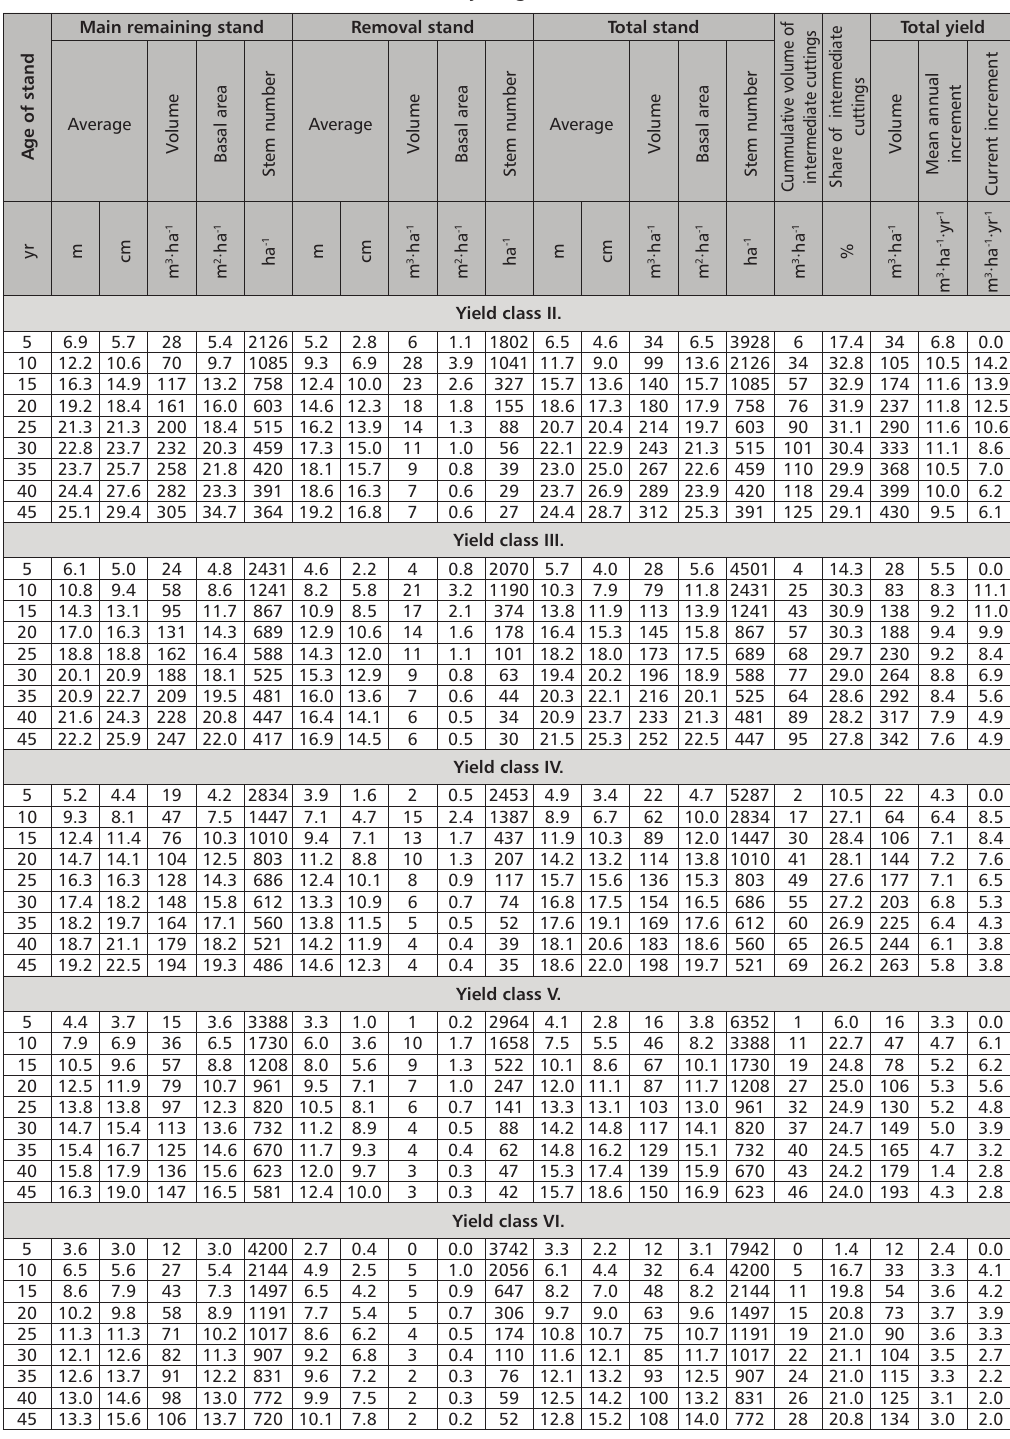
TABle 3. Yield table for black locust stands (Nyírség) -